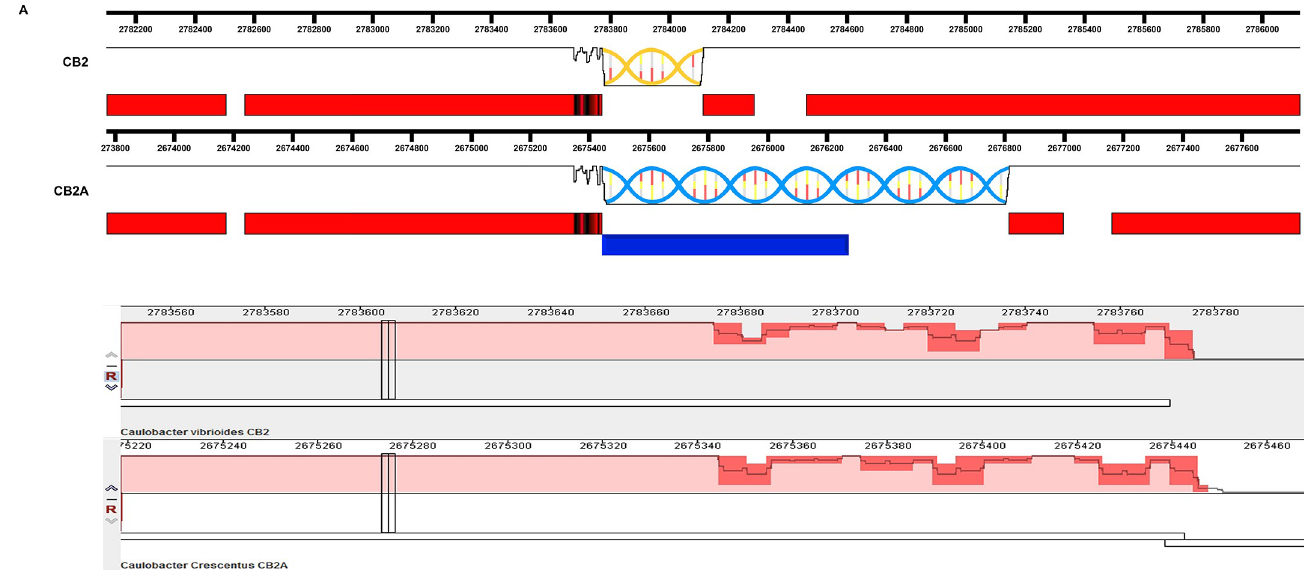
Fig 2. A comparison of the gene insertions in corresponding regions of the CB2 and CB2A genomes. A) The red bars correspond to genes with identical nucleotide sequences in this region of the CB2 and CB2A genomes with the vertical black bars indicating a part of the gene where the CB2A gene was identical to the NA1000 gene sequence instead of the CB2 gene sequence. The helical regions represent sequences that are unique to each genome. The blue helical region is identical to the corresponding region in the NA1000 genome, and the blue bar corresponds to a NA1000 gene that has been recombined into the CB2A genome. Thus, this NA1000 insert into the CB2A genome corresponds to the region from the leftmost vertical black bar to the right end of the blue helix. The white spaces between adjacent horizontal red bars in each genome represent intergenic regions that have identical nucleotide sequence in both the CB2 and CB2A genomes. The red regions separating the vertical black bars represent small regions where all three genomes are identical. B) A magnification of the region containing the vertical black bars in part A. The darker red regions containing the black line correspond to nucleotide sequence differences between the CB2 and CB2A genomes. The depth of the black line corresponds to the average percent identity of a sliding window comparing the two genomes. The CB2A nucleotide sequence in this region and the region to the right of it (the helix in part A) is identical to the corresponding region of the NA1000 genome. The sequences of the CB2 and CB2A genomes are identical in the region to the left of the darker red